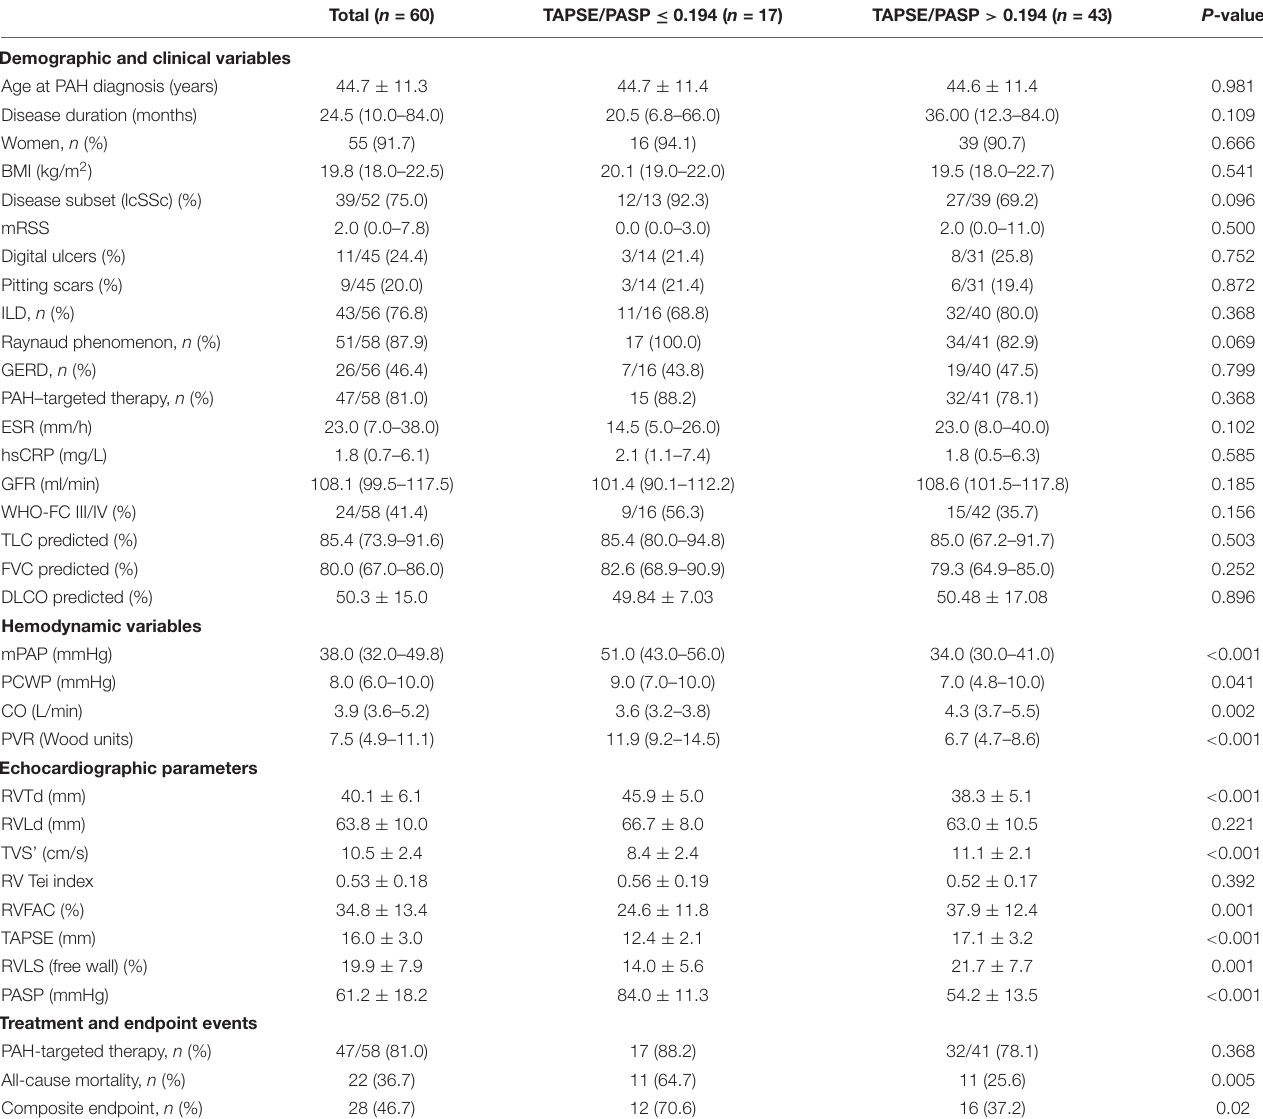
TABLE 1 | Baseline characteristics and comparison of variables based on optimal cut-off for RV-PA coupling. Total ( n = 60) TAPSE/PASP ≤ 0.194 ( n = 17) TAPSE/PASP > 0.194 ( n = 43)